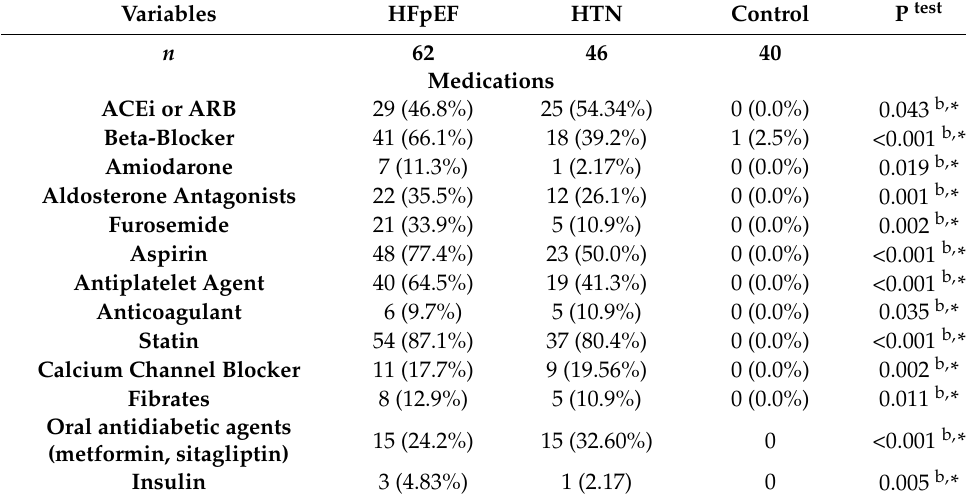
Table 2. Comparison of prevalent use of medications in the three groups ( n =